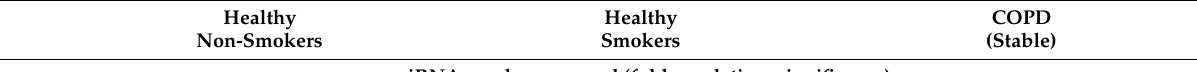
Table 2. Over-and under-expressed miRNA targets that were identified to be significantly ( p < 0.05) dysregulated between lung cancer participants and comparator cohorts (healthy non-smokers, healthy smokers and stable COPD